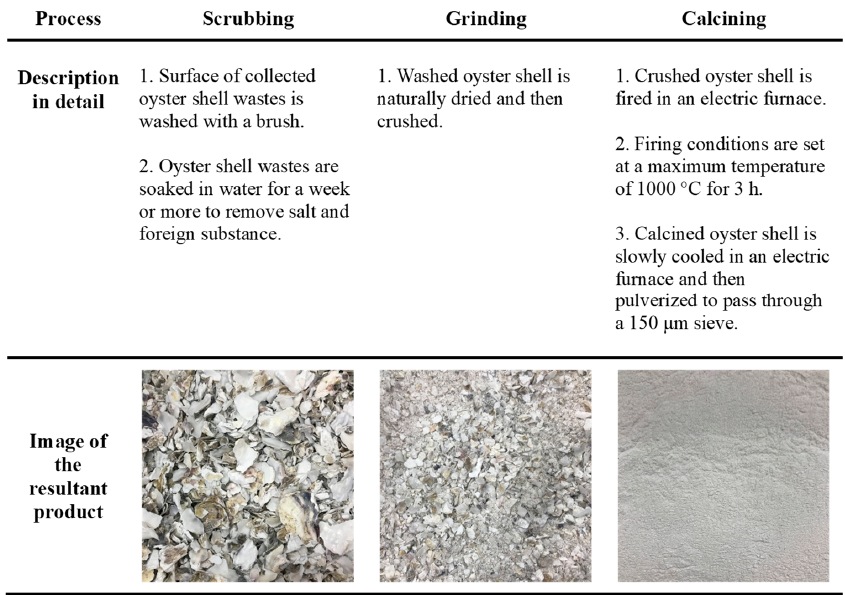
Figure 1. Manufacturing of calcium oxide powder through calcination of oyster shell waste.